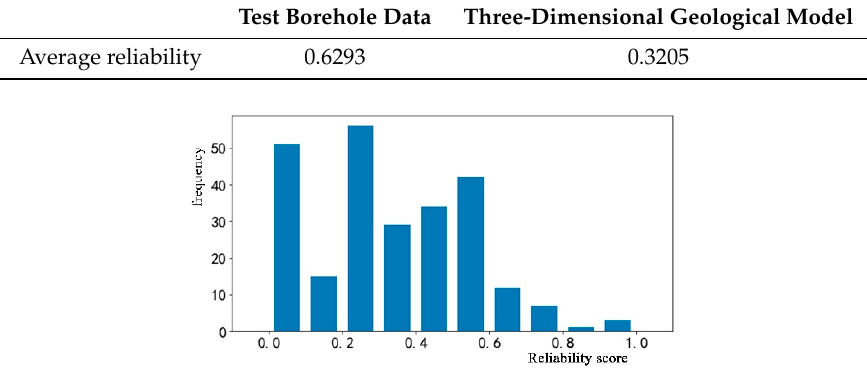
Figure 43. Histogram of the reliability index frequency of the 3D geological model.